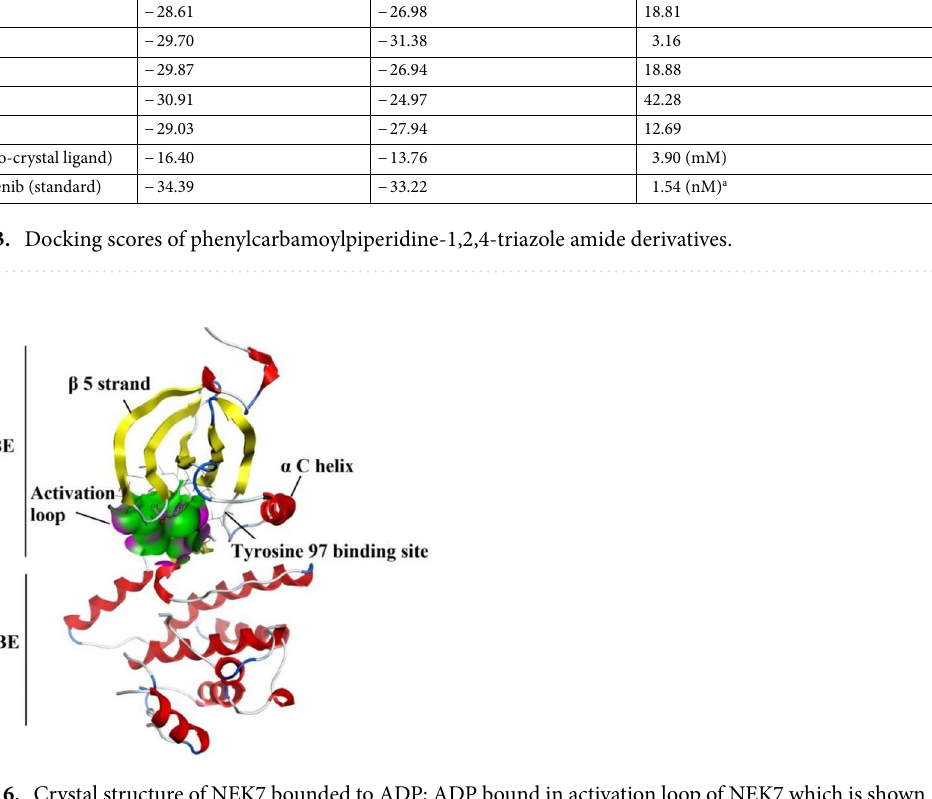
Figure 6. Crystal structure of NEK7 bounded to ADP; ADP bound in activation loop of NEK7 which is shown as green and pink